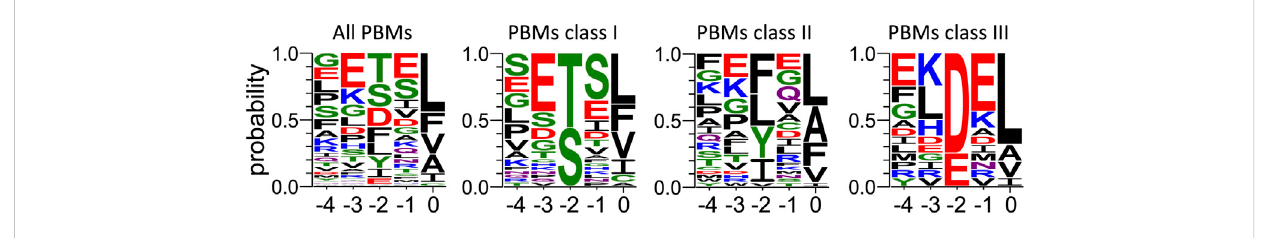
FIGURE 5 Frequency plot of the C-terminal residues of the PBM-containing partners of PTPN3-PDZ identi fi ed from cell lysate by pull-down. For each extension, all UniprotKB sequences were aligned (Supplementary Material S3). The result is displayed using a logo representation (Crooks et al., 2004),